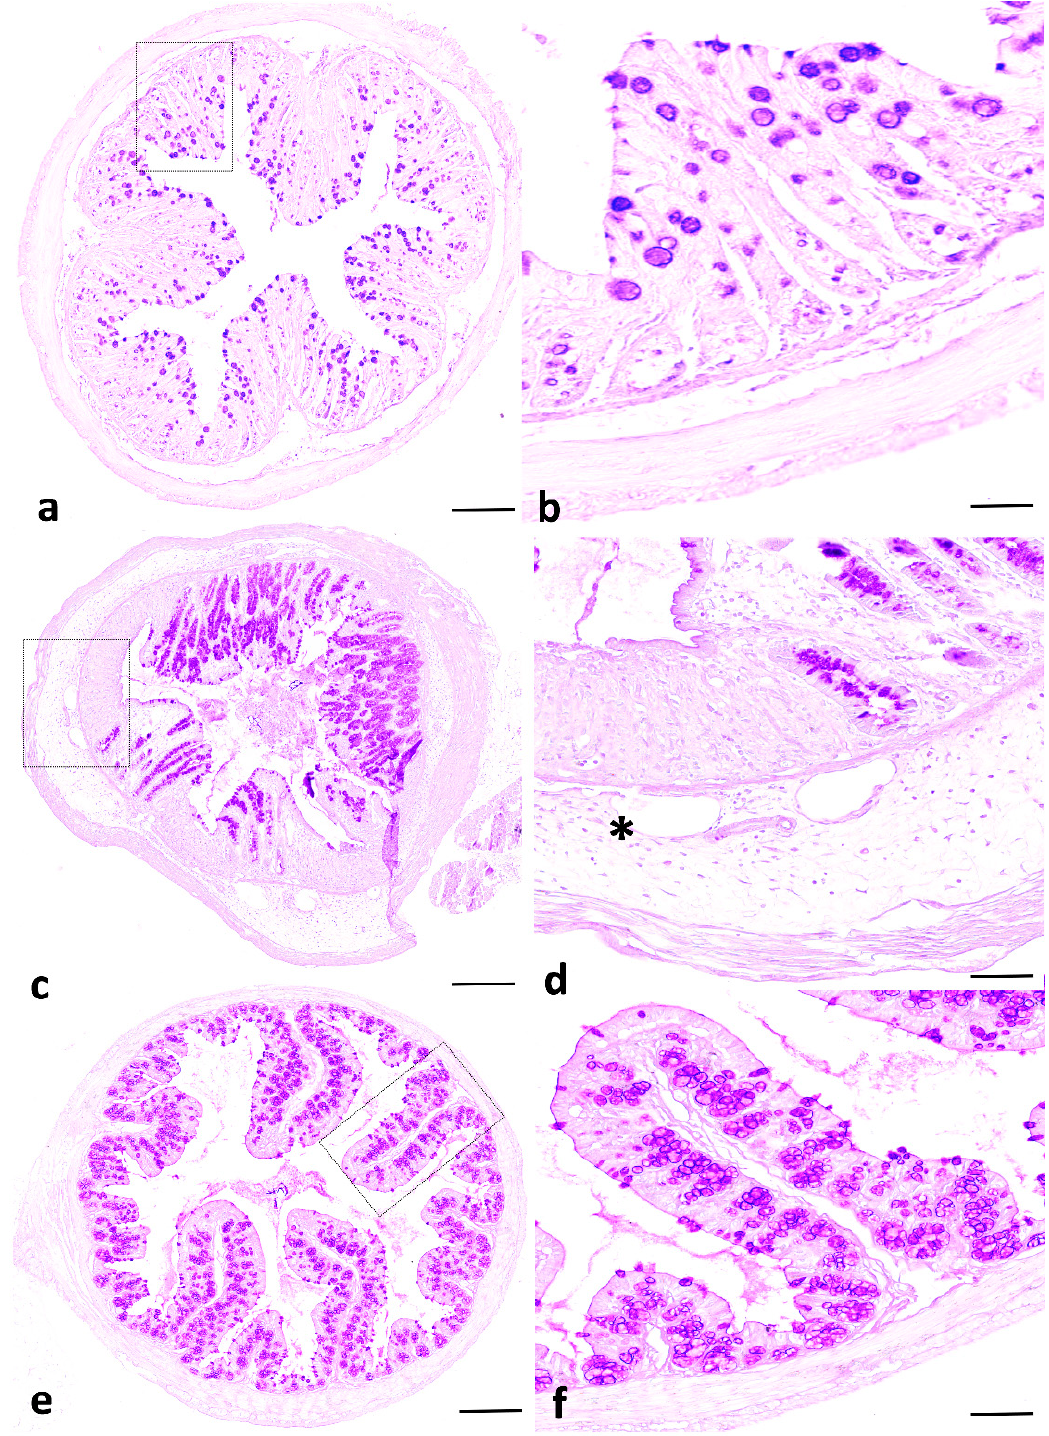
Figure 2. Histological analysis of colons from mice with dextran sulfate sodium (DSS)-induced colitis. Panels ( a ) and ( b ) display sections from mice that received C. albicans; panels ( c ) and ( d ) correspond to C. albicans + DSS; and panels ( e ) and ( f ) denote colon sections from mice that received C. albicans + DSS + intravenous immunoglobulin (IVIg). C. albicans alone did not induce any epithelial injury or an inflammatory cell infiltrate in the colon wall structure. Colon sections from DCa mice show an inflammatory cell infiltrate in colon wall structures and massive tissue destruction (asterisk), while colon sections from DCaIVIg mice show minimal tissue damage. The scale bars represent 50 µm ( a , c, and e ) and 10 µm ( b , d, and f ).